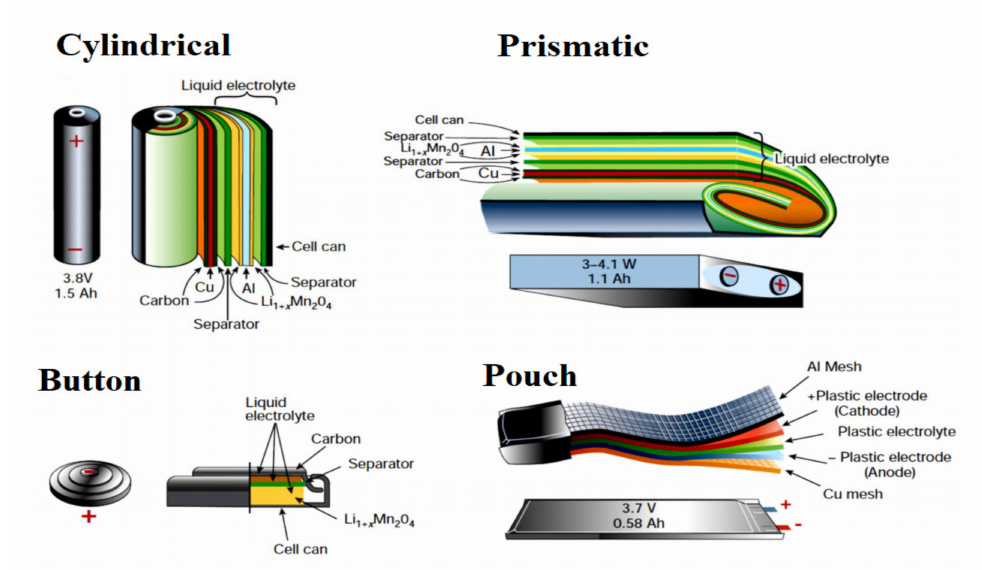
Figure 1. Different commercially available cell types [4].